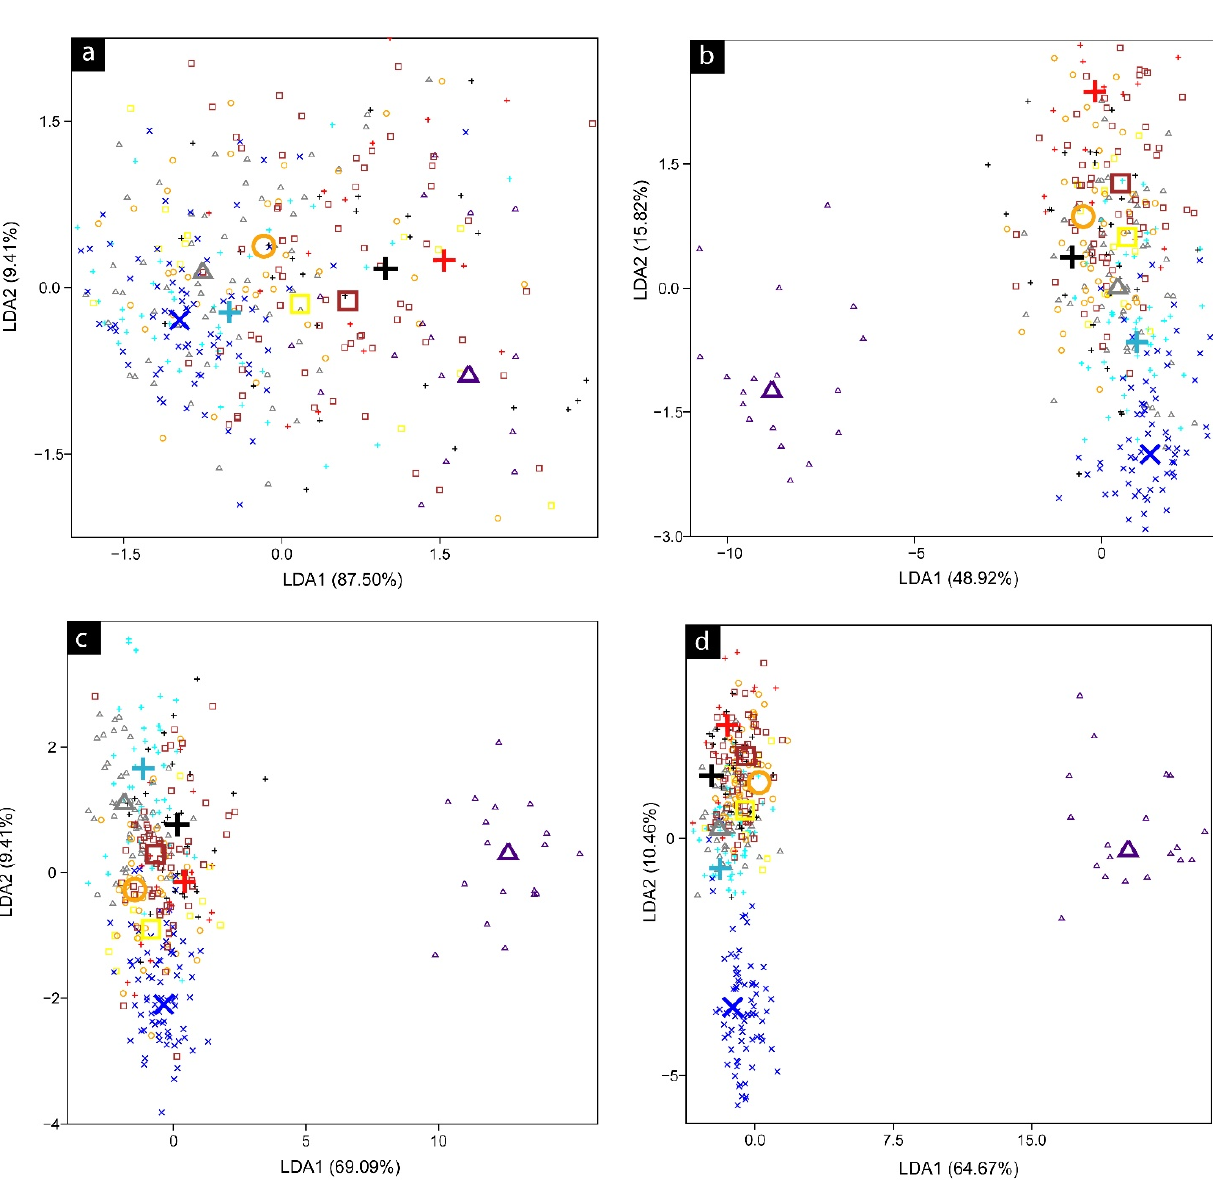
Figure 5. Linear Discriminant Analysis ( a ) Morphometric indices (MI); ( b ) Wavelets coefficients (WC); ( c ) Fourier descriptors (FD); ( d ) MI + WC + FD. MDQ: Mar del Plata; QQN: Quequén; CLM: Claromecó; MTH: Monte Hermoso; LCH: La Chiquita; SBL: San Blas; ELC: El Cóndor; SAE: San Antonio Este; PLB: Puerto Lobos. The centroid of each study area is shown as a larger symbol. Table 4. Overall PERMANOVA comparison among groups for combined silverside otolith shape indices, Fourier descriptors and Wavelet coefficients, including pairwise comparisons between MI, FD and WC together (Table 3d). Figure 5d shows that the locality of PLB was separated from the rest on canonical axis 1, showing a North–South gradient on presented a classification more in line with the geographical reality of the localities evaluated, showing, in addition, the lowest percentage of misclassification (Table 3).